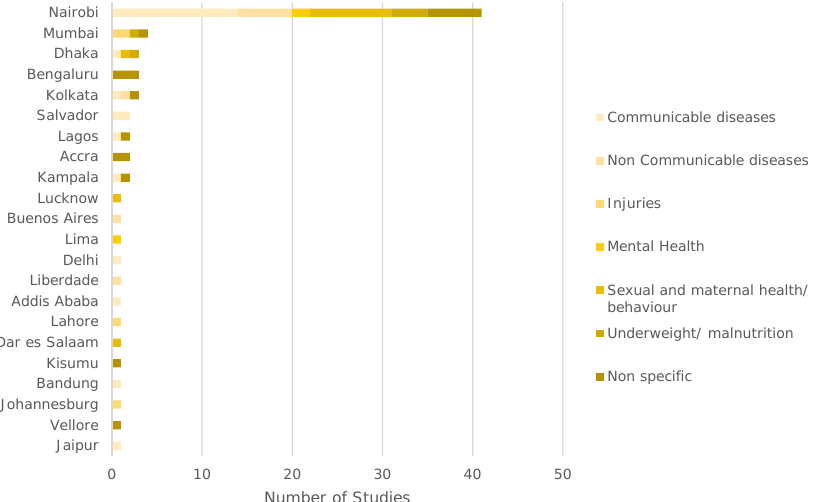
Figure A1. This figure shows the number of studies per city on slum scale. The colors label the health categories of the